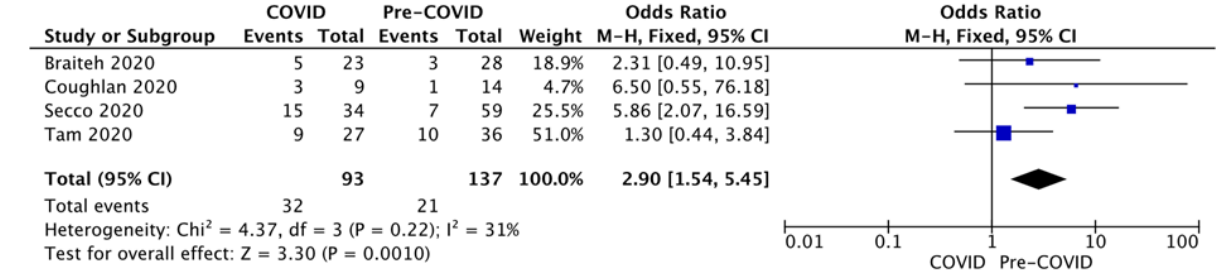
Figure 8. Forest plots for presentation delay >24 h.